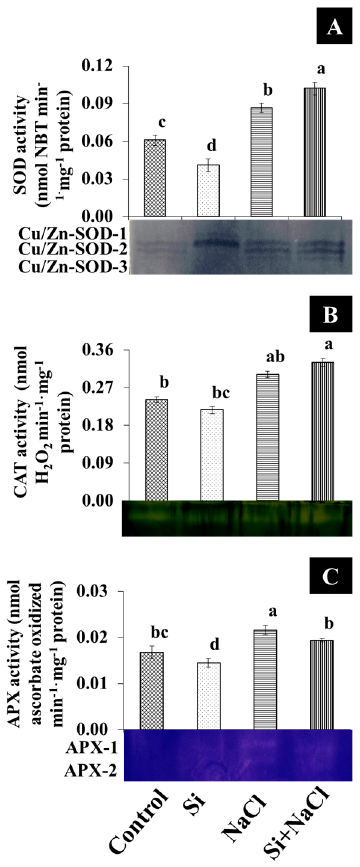
Figure 5. Activity and isozymes pattern of antioxidant enzymes such as superoxide dismutase ( A ), catalase ( B ), and ascorbate peroxidise ( C ) under salt stress with or without Si supplementation. Data are the mean ± SD from three replicates. Different letters indicate that treatments are significantly different at p ≤ 0.05.